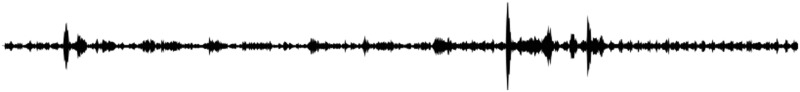
Waveform generated by the wavesurfer.js library (from: http://bio.acousti.ca/node/11778).